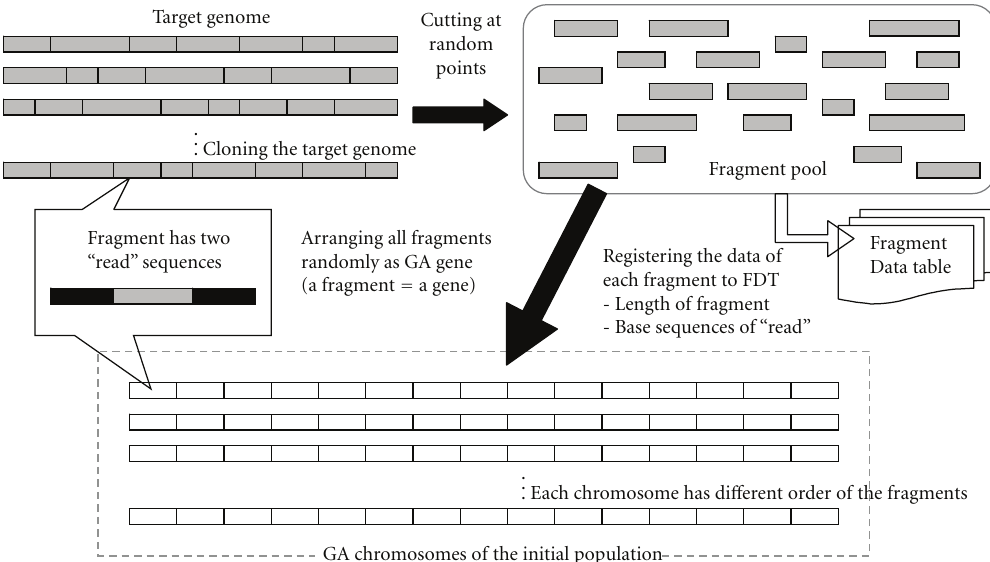
Figure 3: Chromosomes of GA for fragments